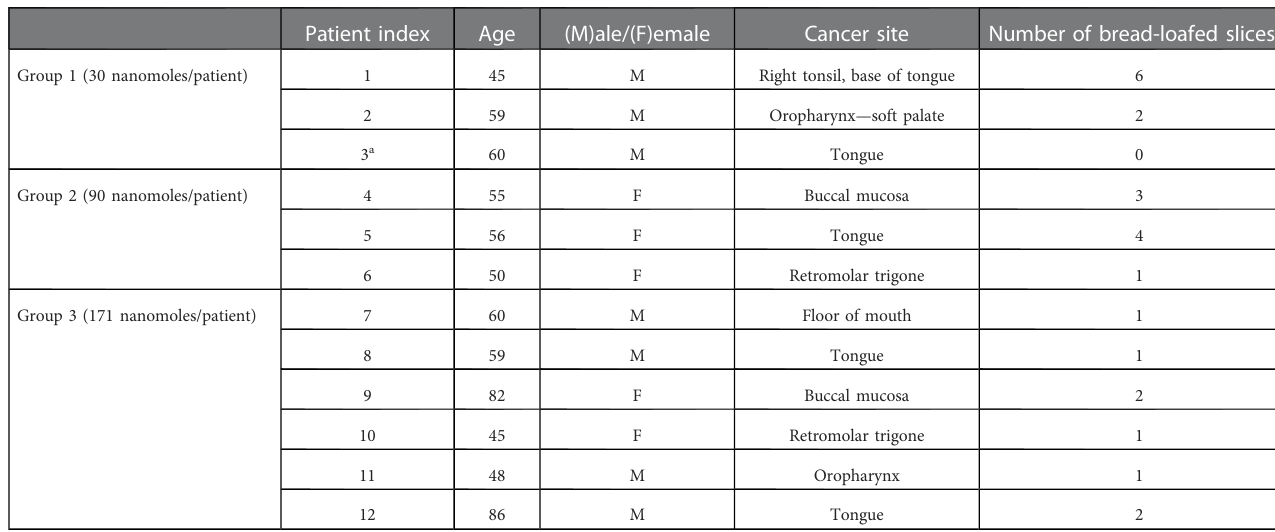
TABLE 1 Dose groups and patient